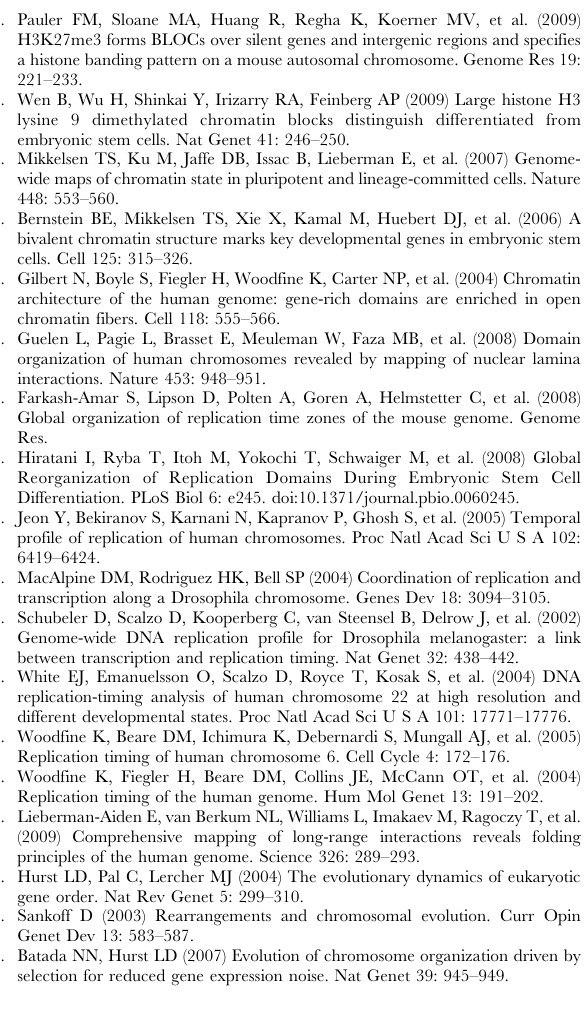
phylo-tree, the human and the mouse coordinates, and the strand (direction in each genome where the syntenic block